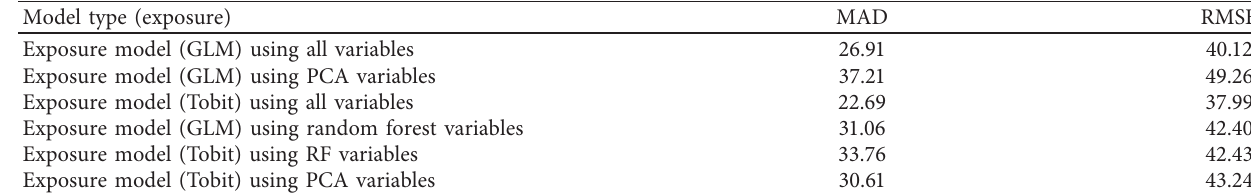
Table 4: Comparison of the exposure models developed in the study.